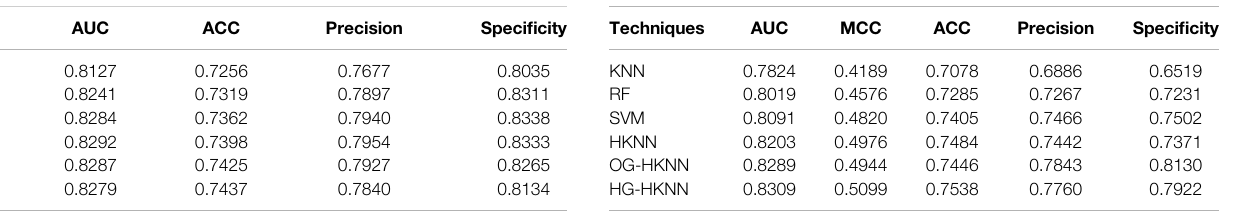
TABLE 2 | Details in parameter tuning of k .